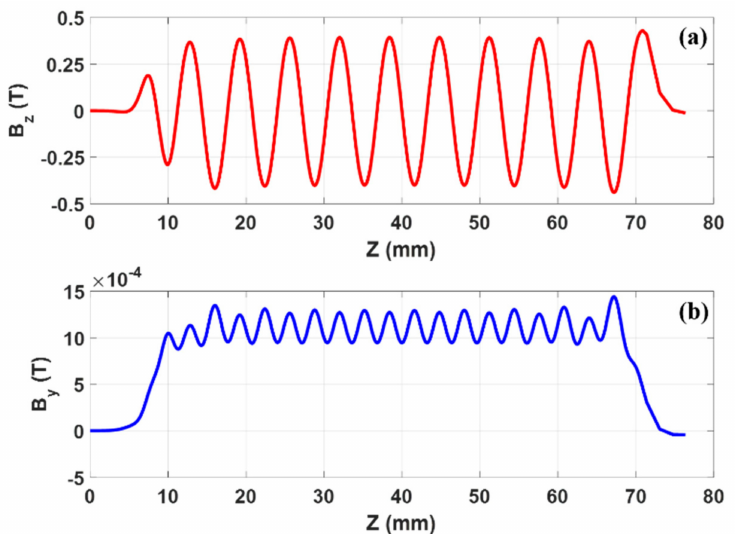
Figure 6. Design results of the focusing magnetic fields: ( a ) the on-axis distribution of B z , ( b ) the side magnetic field B y ,side at X = ± 0.3 mm and Y = 0.